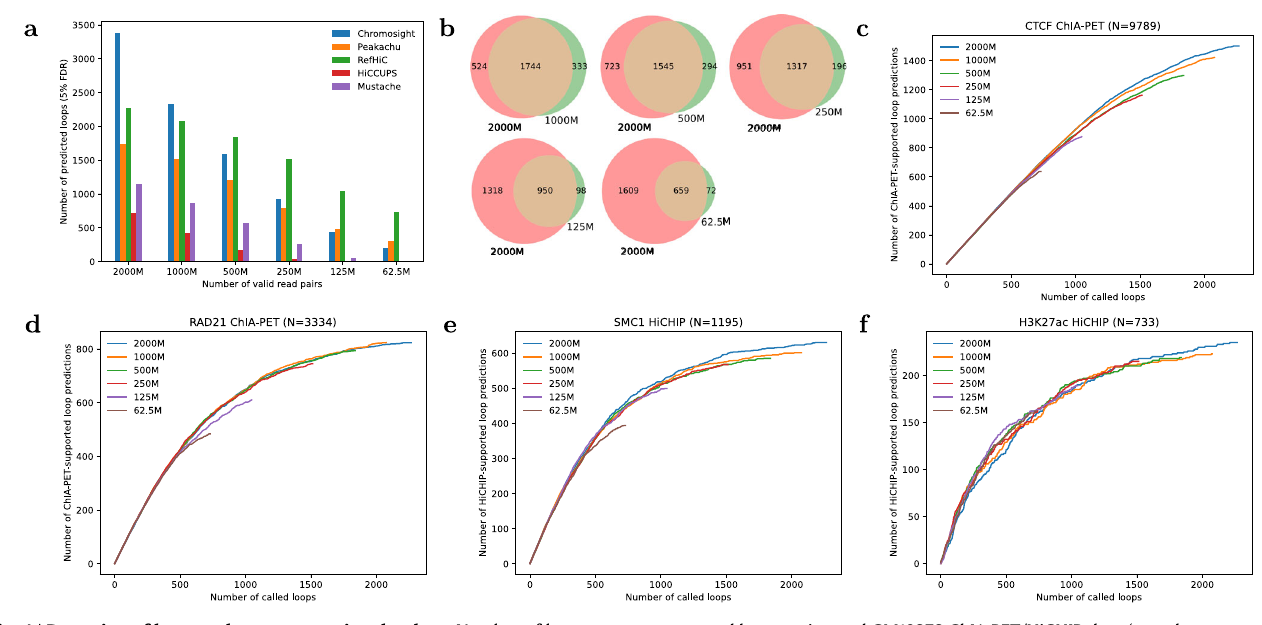
supported by experimental GM12878 ChIA-PET/HiCHIP data (test chromosomes chr15-17) at different levels of sequencing coverage: CTCF ChIA-PET ( c ), RAD21 ChIA-PET ( d ), SMC1 HiCHIP ( e ), H3K27ac HiCHIP ( f